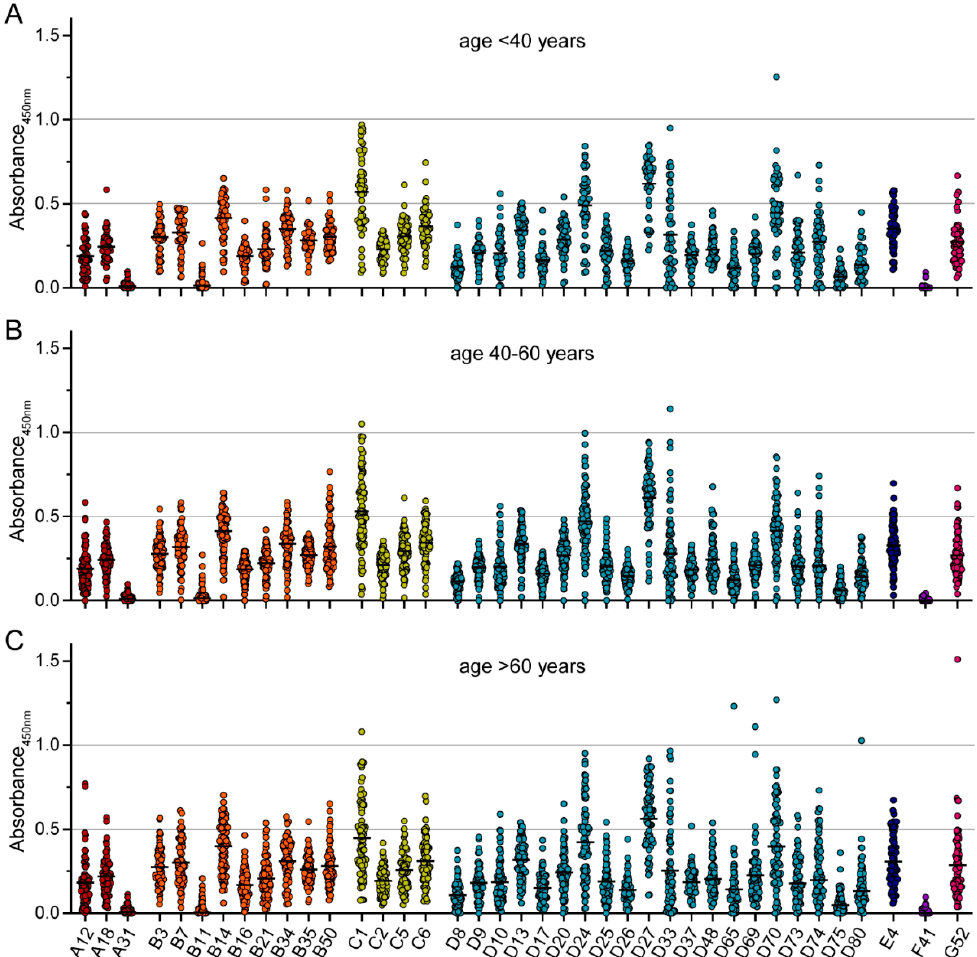
Figure 3. Binding antibody levels stratified by age of serum donors. The data presented in Figure 1 were stratified by the age of the serum donors and grouped as ( A ) below 40 years of age ( n = 49), ( B ) 40 to 60 years of age ( n = 84), and ( C ) older than 60 years ( n = 76). Each dot represents an individual sample, lines indicate mean values of all sera for the indicated HAdV type. No statistically significant differences in binding antibody levels of the different age groups were found using Kruskal-Wallis one-way ANOVA on ranks and Dunn’s multiple comparisons test.